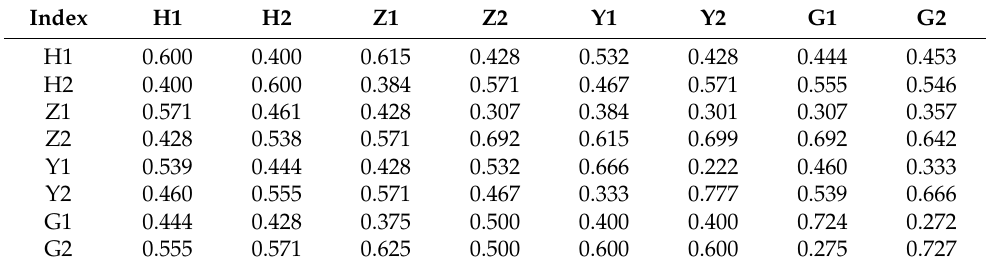
Table 1. Unweighted super matrix.